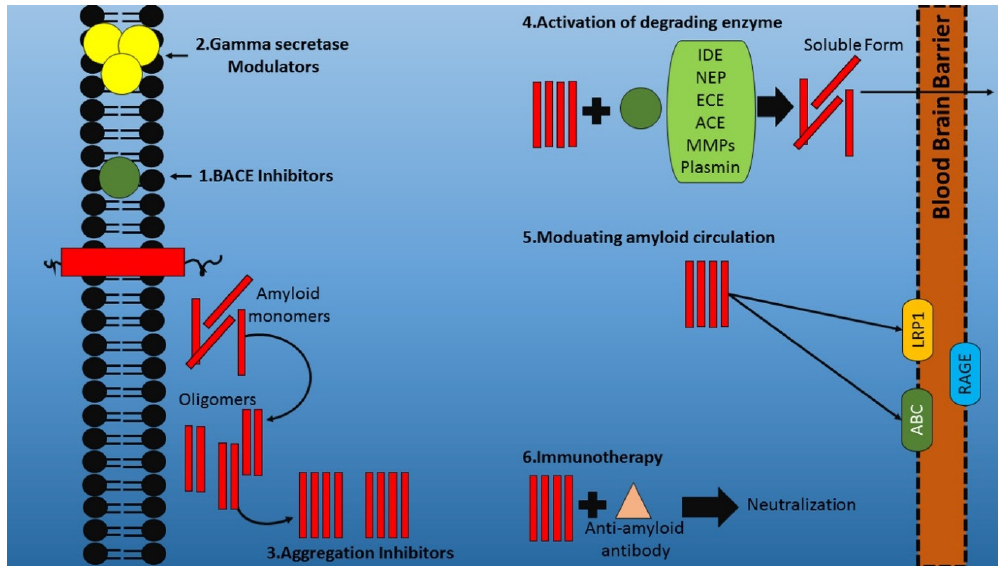
Figure 2. Therapeutical agents targeting the events in the amyloid beta (A β ) hypothesis. BACE—Beta- site APP-cleaving